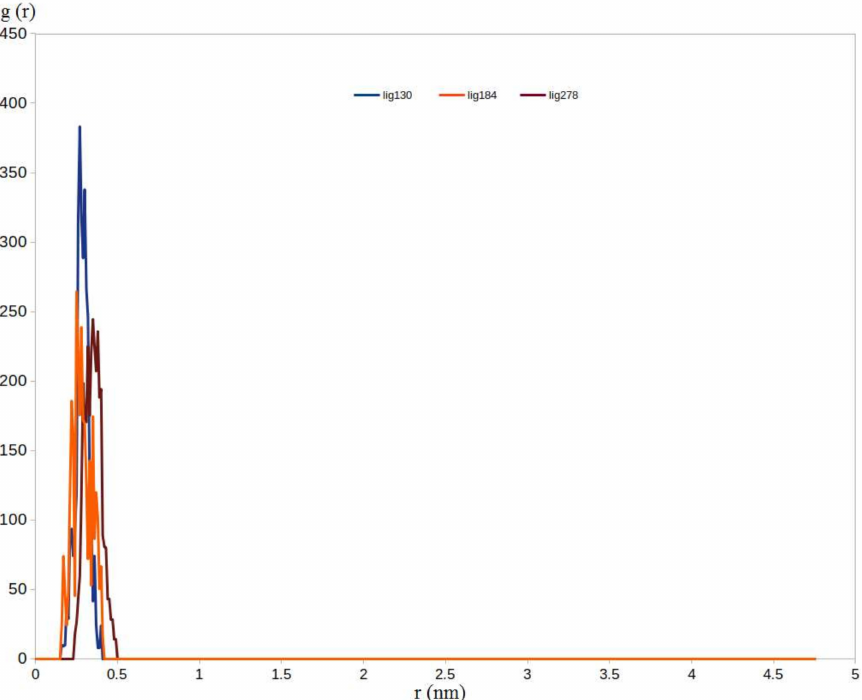
Figure 11. Radial distribution function (RDF) for the three ligands ( 130 , 184, and 278 ) on the surface of the M pro enzyme.